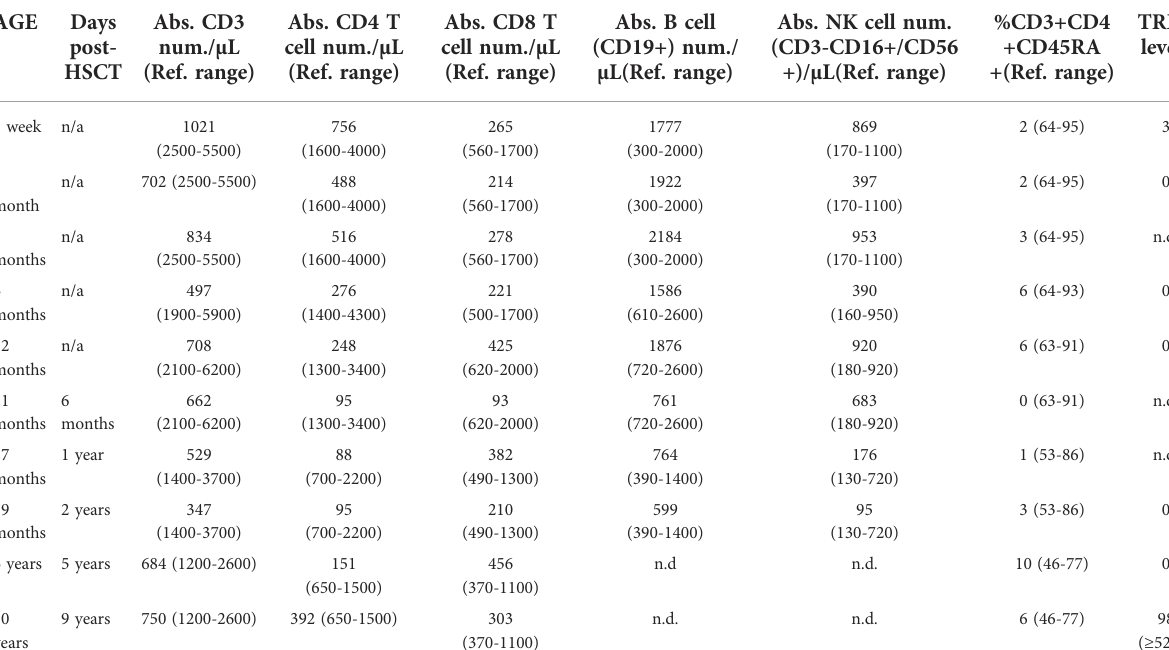
TABLE 2 Patient Immune Characteristics.